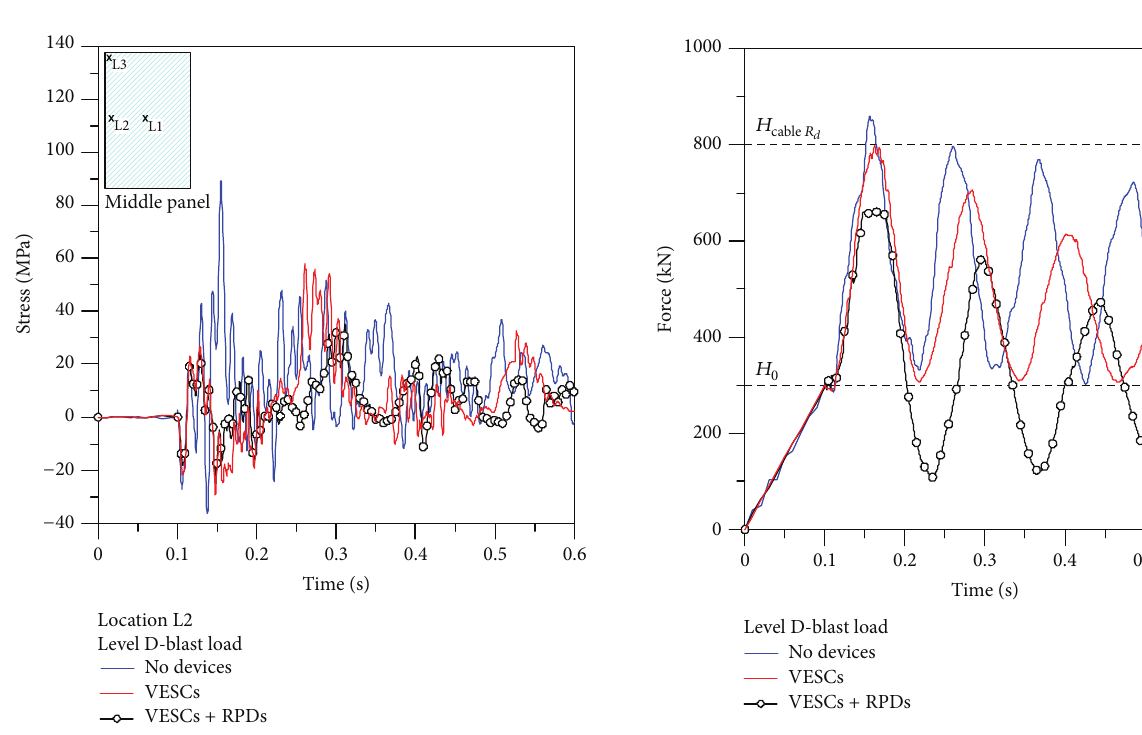
Figure 10: Maximum axial force in the cables as a function of time